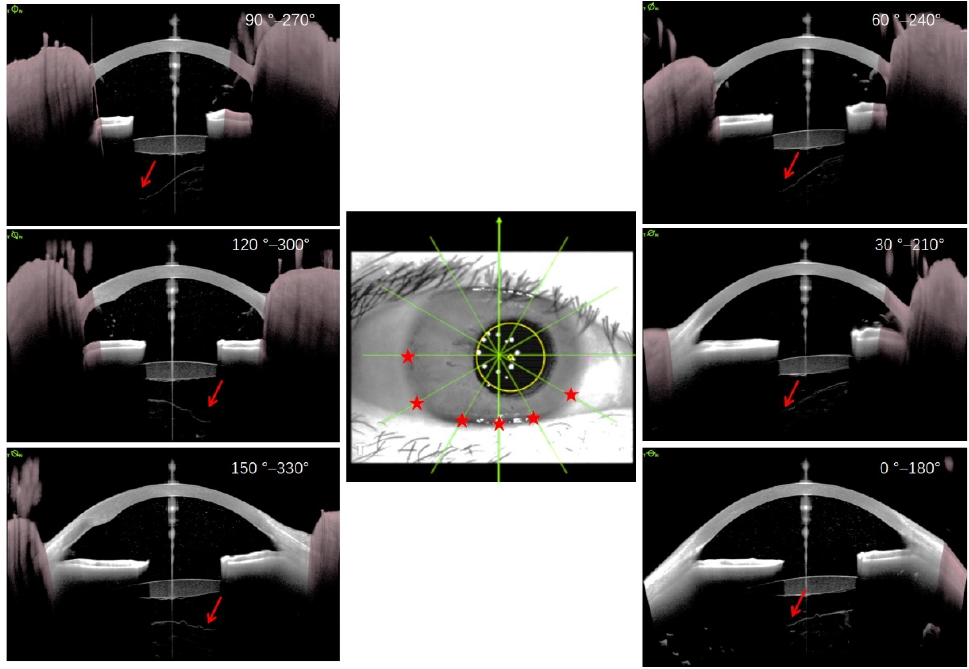
Figure 4. A representative eye postoperatively presented with uneven Berger’s space. Berger’s space lost its symmetry in all directions and the larger width was predominantly observed in the opposite area of the main clear corneal incision (red arrows in cross ‐ sectional optical coherence tomography (OCT) images and red stars in eye plane image).